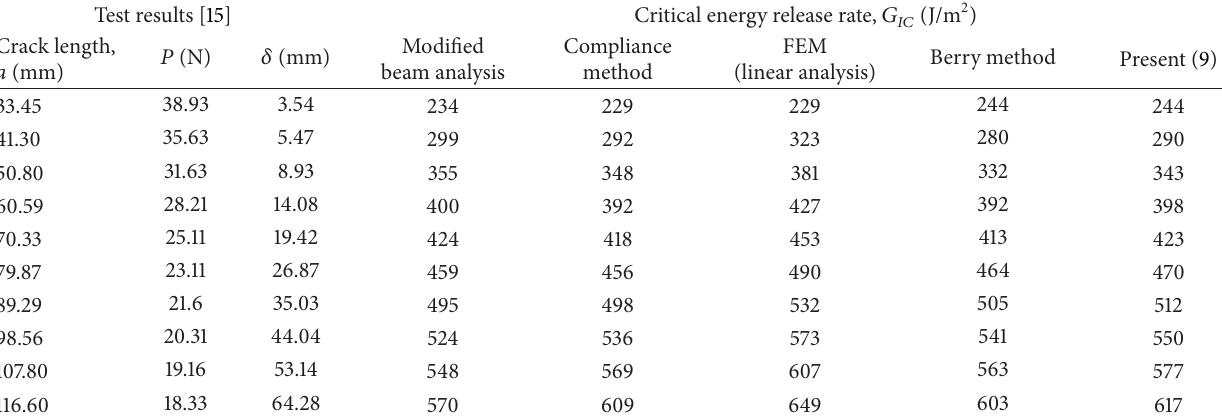
Table 1: Comparison of mode-I delamination fracture toughness of glass/epoxy composite by different data reduction schemes. Test results [15]